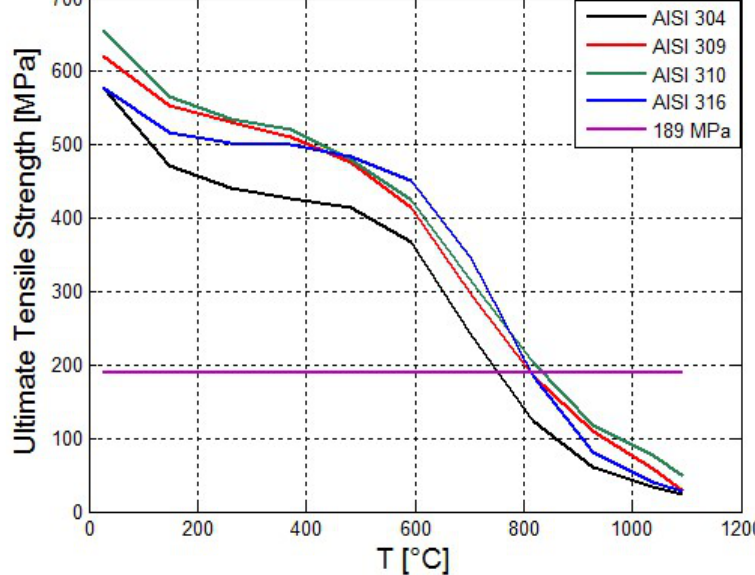
Figure 3. Plot of ultimate tensile strengths of several stainless steels compared to the material stress exerted by the pressurized Propane (horizontal line) shown as a function of temperature (The thermomechanical data were taken from Reference [21]).